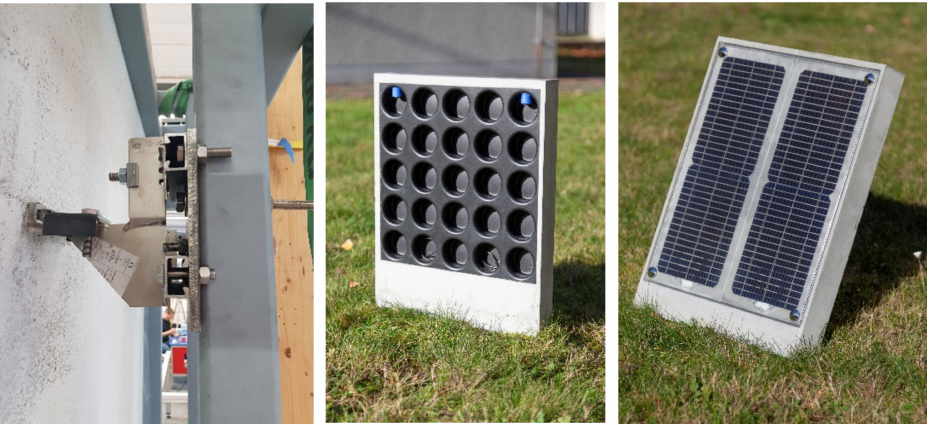
Figure 6. Electrically activatable connection made of shape memory alloy ( left ); CRC panel with integrated photovotaics, voids, and capillary system, taken from [44] ( middle and right